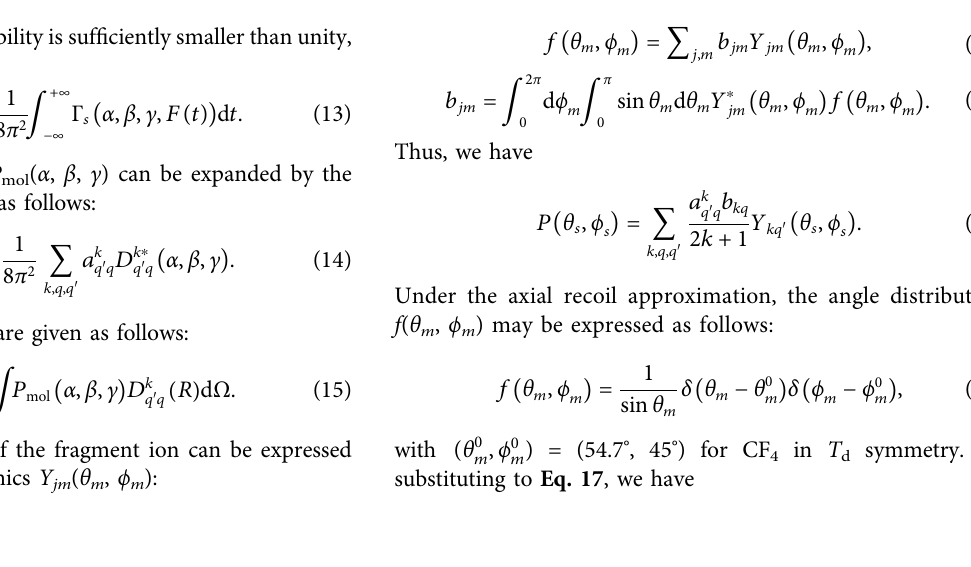
Frontiers in Chemistry |